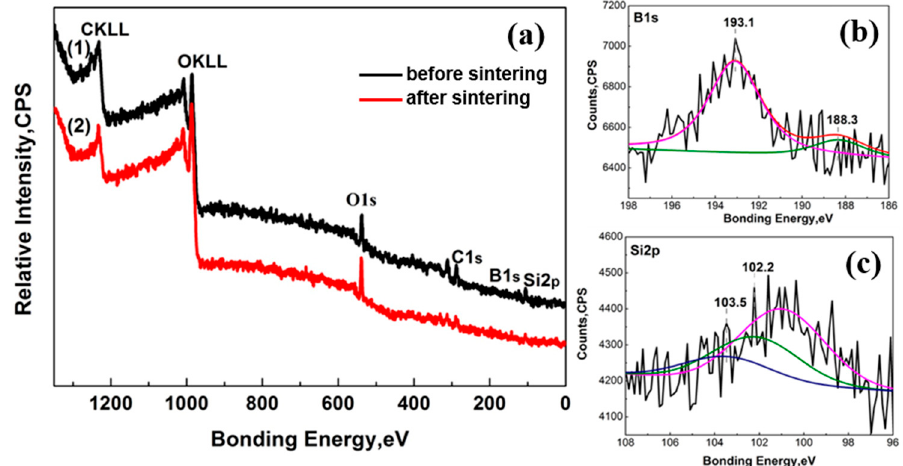
Figure 9. ( a ) Wide-scan XPS spectra of the coating: (1) Before sintering and (2) after sintering; ( b ) B1s spectra of the coating after firing, ( c ) Si2p spectra of the coating after sintering.